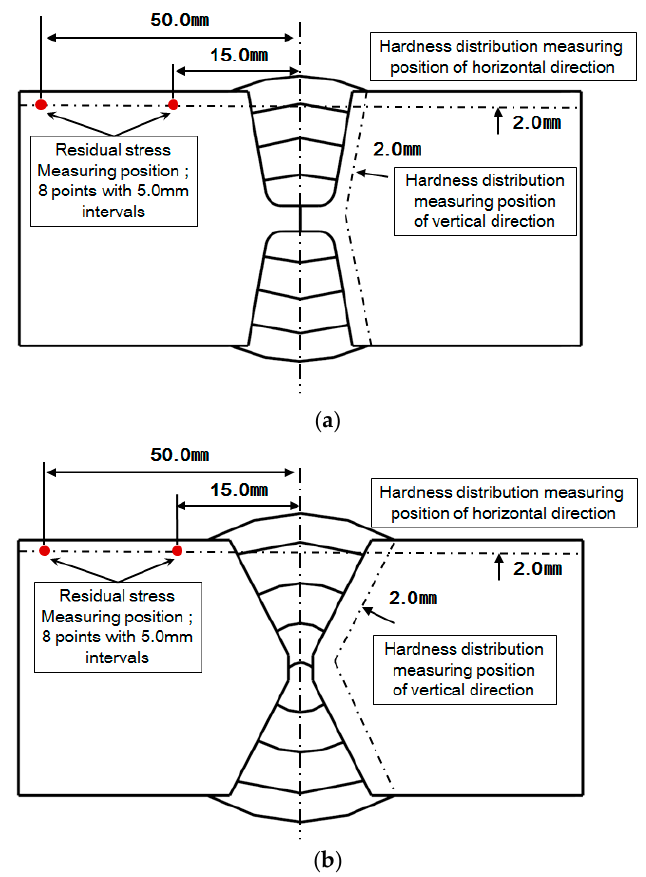
Figure 5. ( a ) Measuring position of the hardness distribution and residual stress of NGW. ( b ) Measuring position of the hardness distribution and residual stress of X-groove.